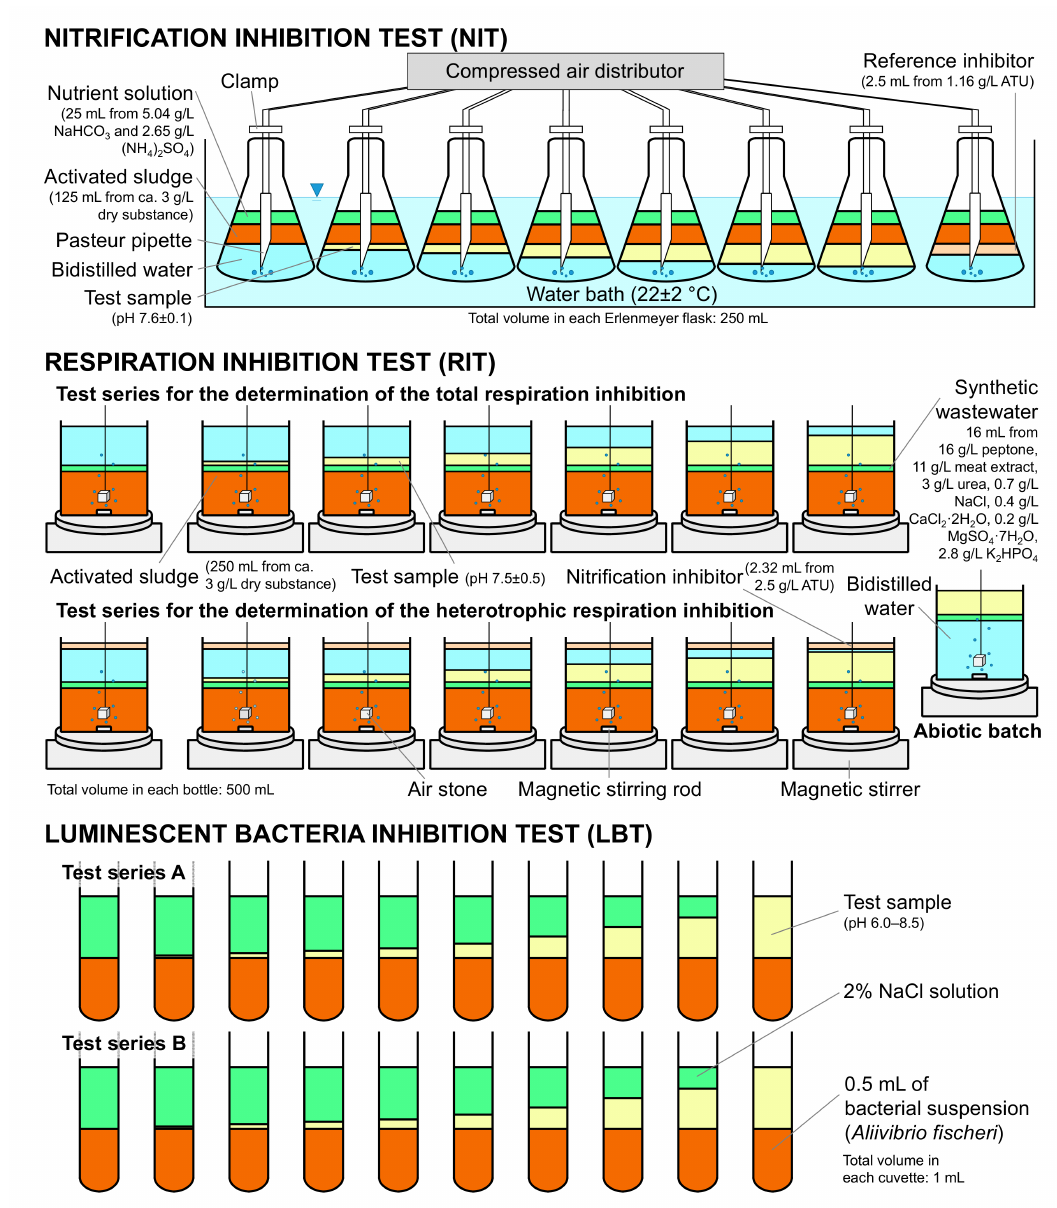
Figure 1. Construction of the bacterial inhibition tests used in this work (ATU: N